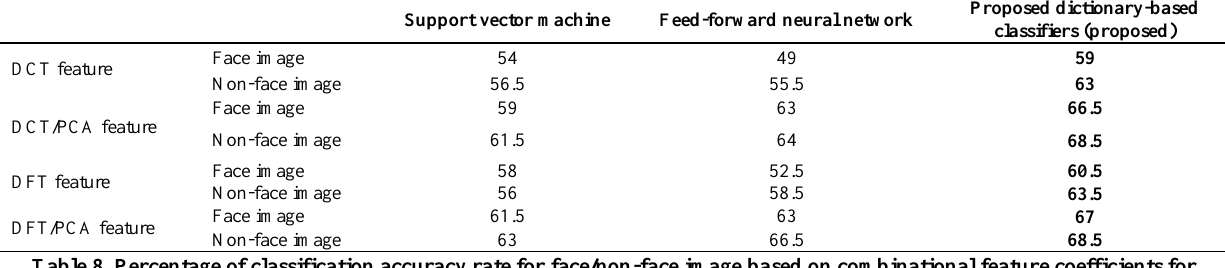
Table 8. Percentage of classification accuracy rate for face/non-face image based on combinational feature coefficients for neural network classifications, support vector machine, and proposed dictionary-based